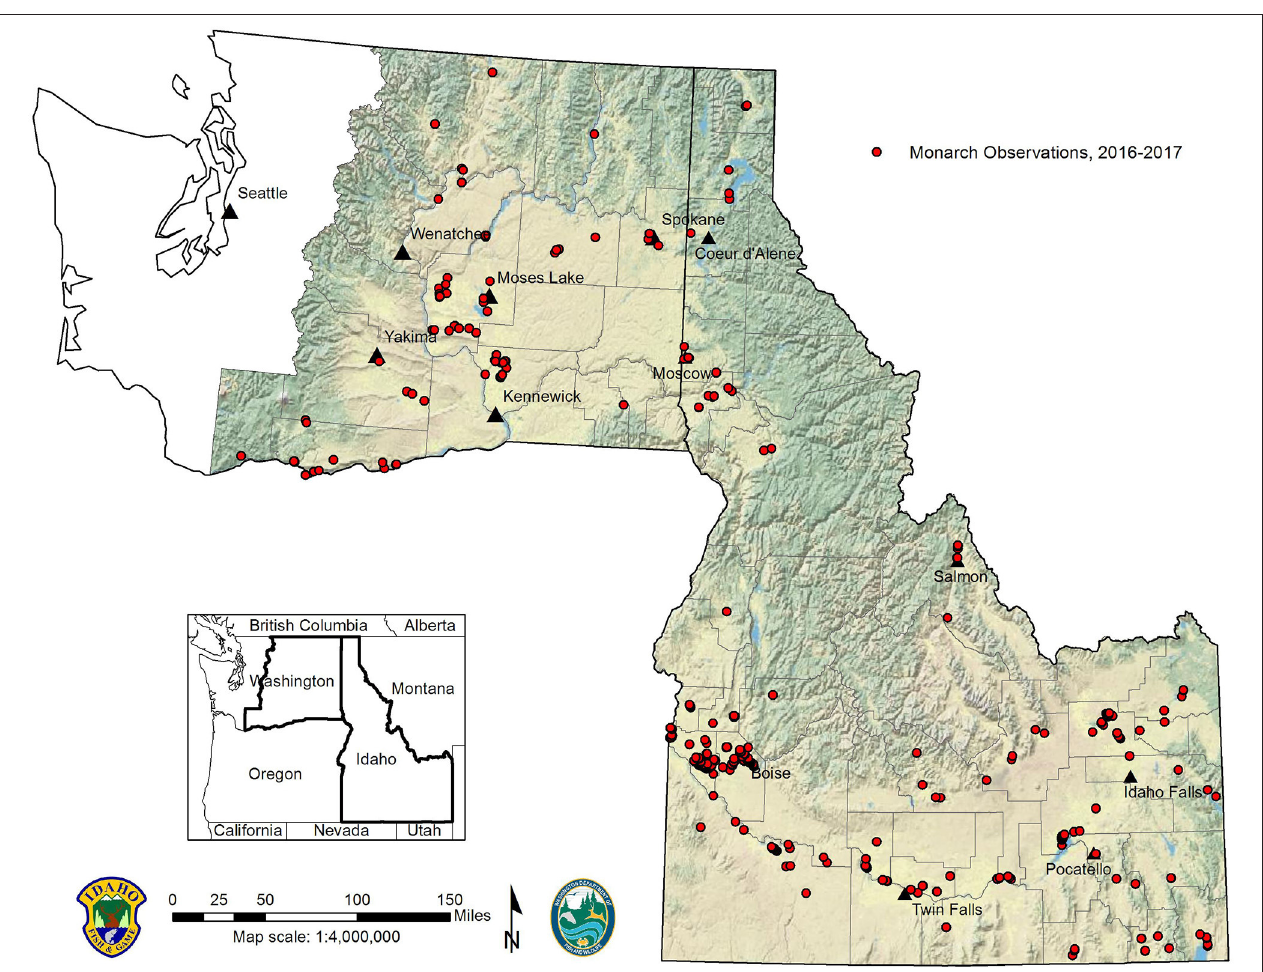
FIGURE 4 | Distribution of monarch observations in Idaho and Washington, 2016–2017.